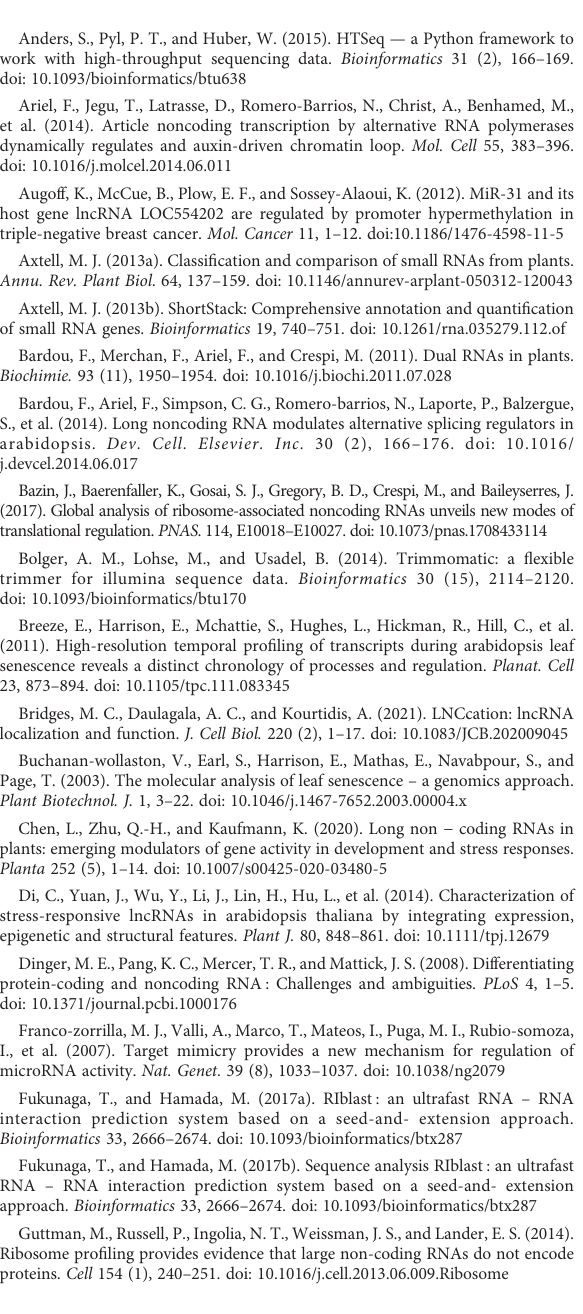
SUPPLEMENTARY FIGURE 5 Changes in senescence-associated gene expression in at1g33415 and at2g14878 during developmental and dark-induced leaf senescence. (A, B) Expression analysis of SAG12 in wild-type (Col-0), at1g33415 and